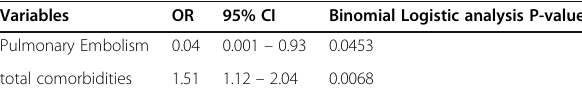
Table 2 (abstract A107). Significant variables in the Stepwise logistic multivariate analysis were obtained as the main differential factors among patients belonging to Delta and Omicron groups on ICU COVID